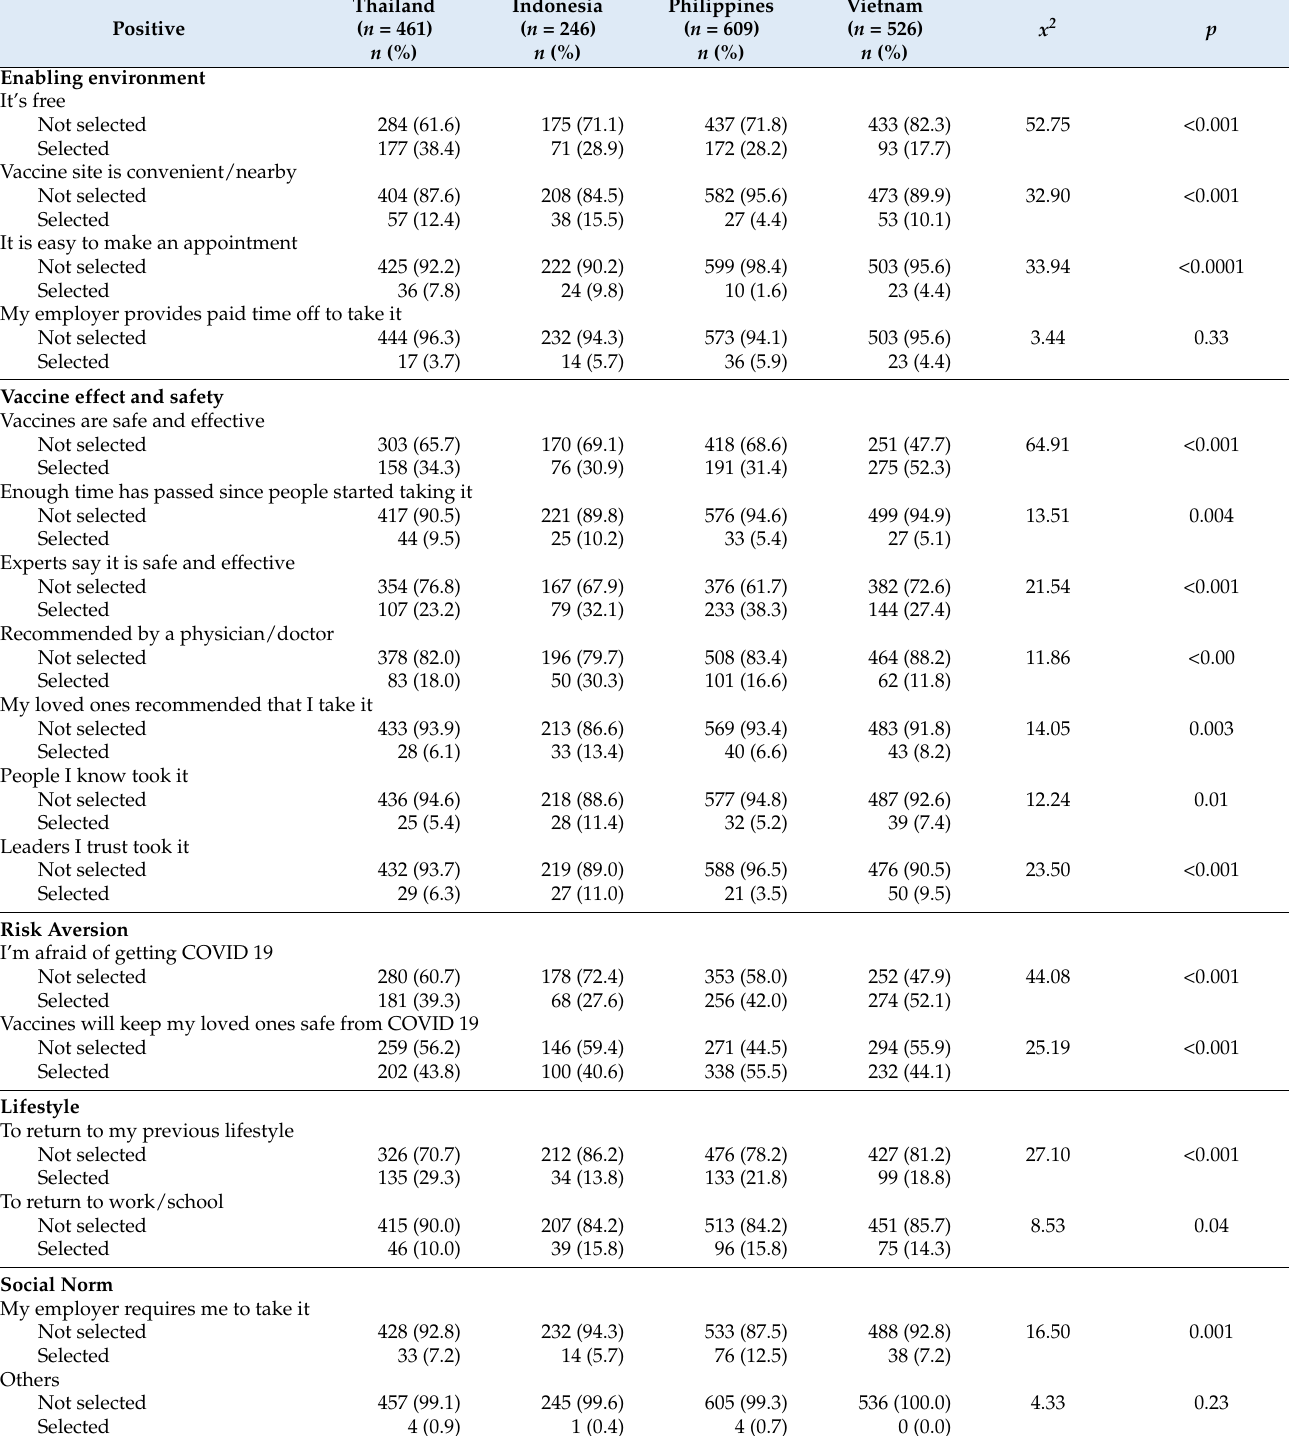
Table 6. Positive reasons (factors) for